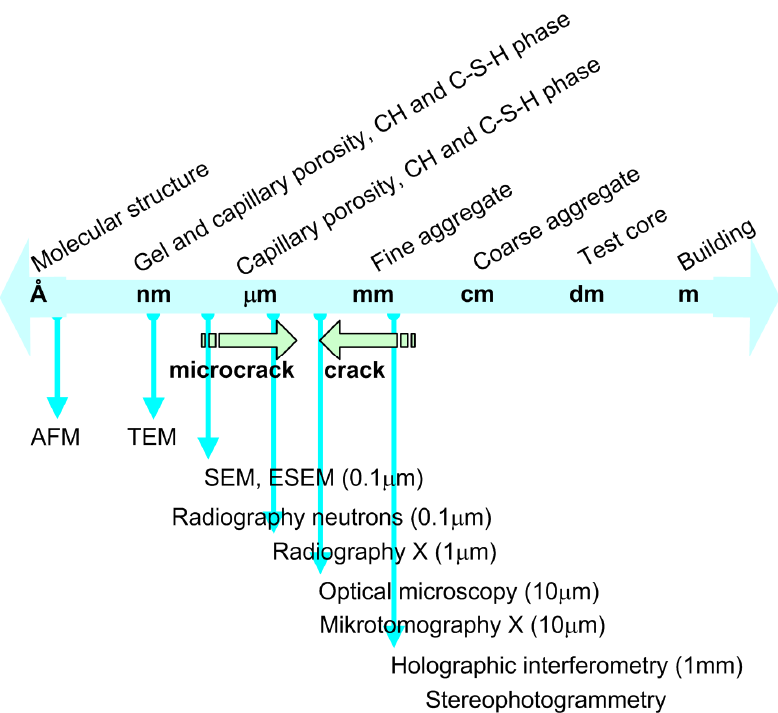
Figure 11. Methods for the detection of microcracks and cracks assigned to di ff erent scales of observation (according to [241]).